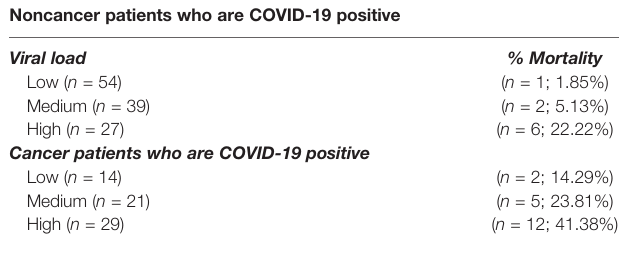
TABLE 2 | Mortality rate of cancer and noncancer patients based on SARS- CoV-2 viral load. Noncancer patients who are COVID-19 positive Viral load